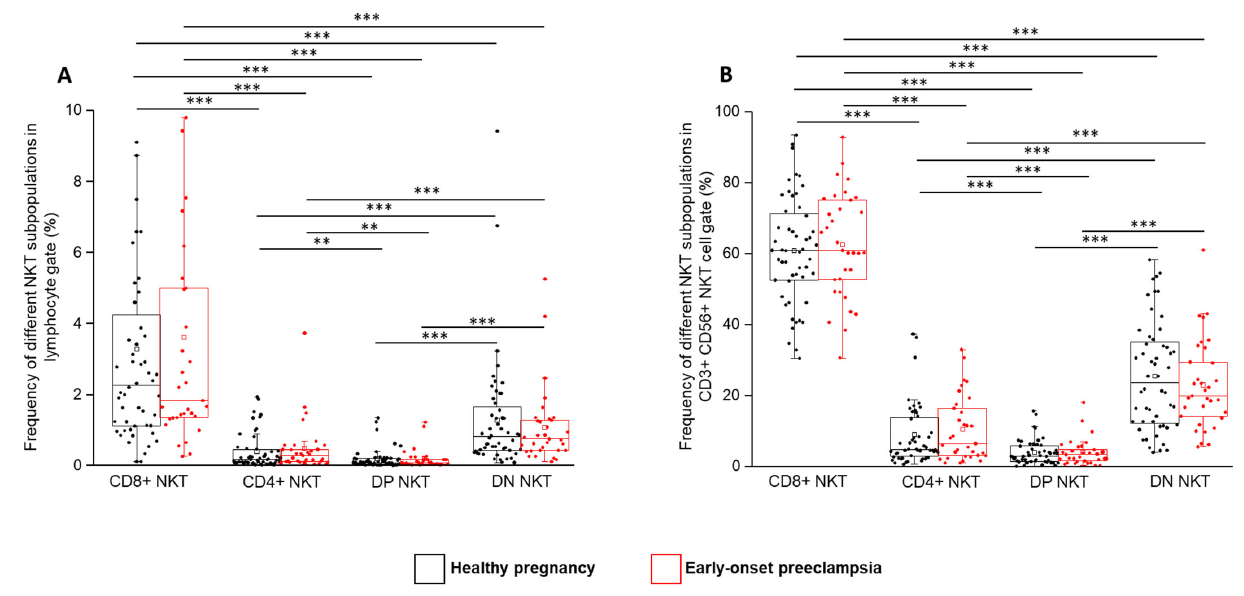
Figure 2. The frequency of different NKT subpopulations in EOP and healthy pregnancy. The frequency of the CD8 ⁺ , CD4 ⁺ , DP, DN NKT cells in the lymphogate ( A ) and the CD3 ⁺ CD56 ⁺ NKT gate ( B ) in EOP patients and healthy pregnant women. The solid bars represent medians of 51 and 32 determinations, respectively. The boxes indicate the interquartile ranges, and the whiskers show the most extreme observations. The middle square within the box represents the mean value. Significant differences with p ‐ values <0.01 *** and <0.03 ** are indicated.